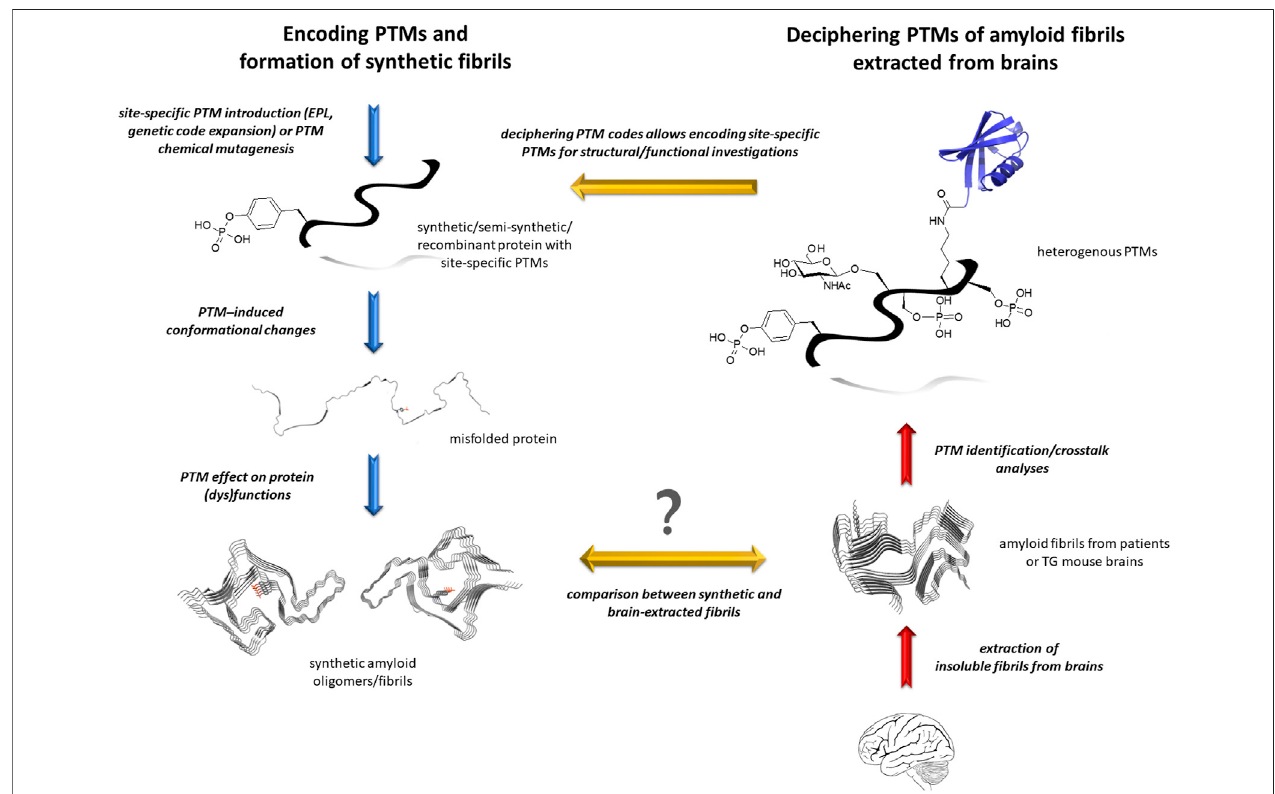
FIGURE 2 | Investigating the role ofPTMs in amyloidogenesis by protein semisynthesis and/or chemical mutagenesis. Amyloid proteins are extracted from patient brains and puri fi ed as insoluble material, then the PTM patterns of amyloid fi brils are deciphered by complementary biophysical and biochemical tools (right panel). The precise role of site-speci fi c PTMs is unraveled by encoding individual PTM or pathological epitope using chemical biology tools. This allows investigating the effect of these speci fi c chemical modi fi cations on protein conformation and function, on oligomer and amyloid assembly, stability and properties (left panel). The synthetic fi bril morphology and cryo-EM atomic structures could thus be compared to bona fi de fi brils from patient brains, here illustrated with pY39 α -synuclein synthetic fi brils (PDB ID: 6LIT) and α -synuclein fi brils from MSA (PDB ID: 6XYO), providing important information about the role of cofactors in amyloid aggregation.